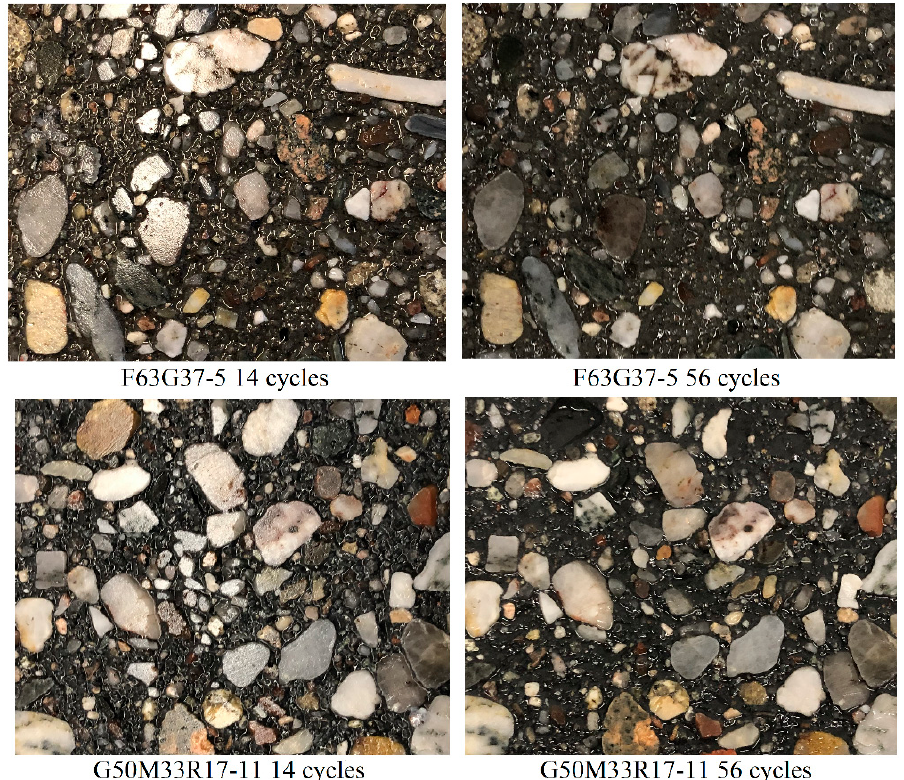
Figure 5. Freeze ‐ thaw specimens’ surface after 14 and 56 cycles. Figure 5. Freeze-thaw specimens’ surface after 14 and 56 Setzer and Auberg [50], in their scaling test study, found that all concrete meeting strictly all the design specifications of standards have a mean scaling below 1.5 kg/m 2 at 28 cycles. Hence they recommended this value to classify a high freeze ‐ thaw resistance concrete. Mix F63G37 ‐ 5 met this requirement with a scaling of 0.7 kg/m 2 at 28 freeze ‐ thaw cycles and even at 56 cycles with about 1.0 kg/m 2 scaling. Mix G50M33R17 ‐ 11, on the con ‐ trary, has a scaling factor of 2.1 kg/m 2 at 28 cycles hence did not meet the requirement.